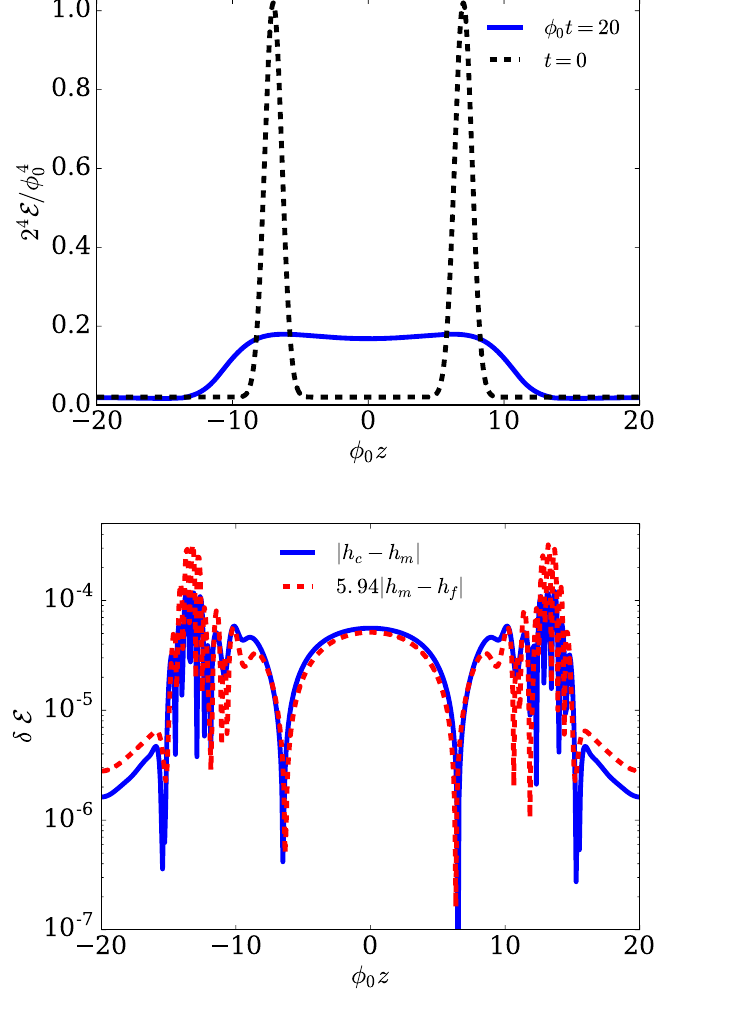
Figure 5 . Energy density at (cid:30) 0 t = 20 (top panel) and correspondent convergence analysis (bottom panel) for a con(cid:12)guration with (cid:30) absolute di(cid:11)erences between the coarse and medium resolution (blue solid line) and the medium and (cid:12)ne (red dashed line) resolution run. The latter has been re-scaled by the factor Q = 5 : 94 expected for fourth order